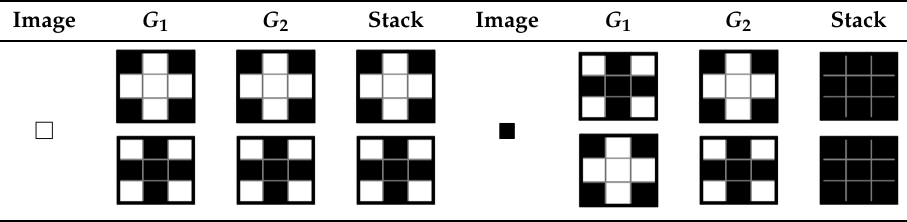
Table 3. The designed patterns for n = 3.